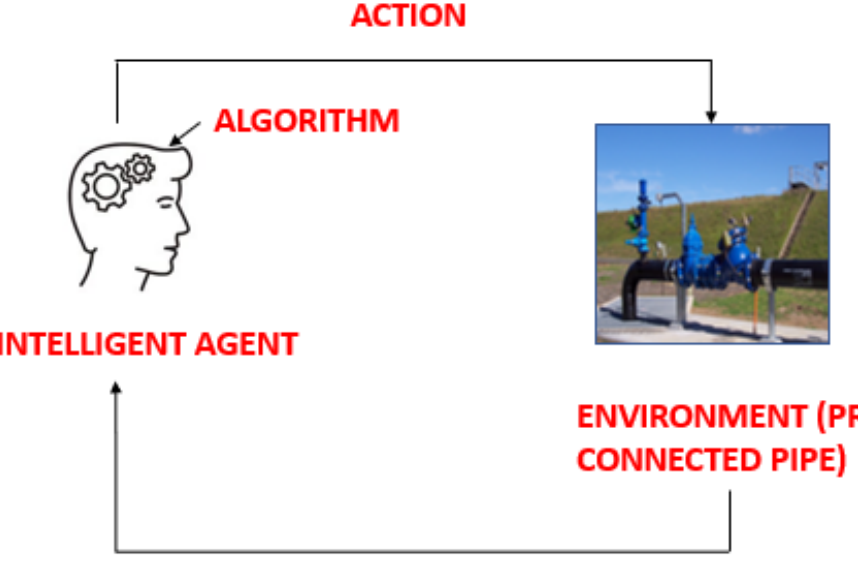
Figure 1. Reinforcement learning